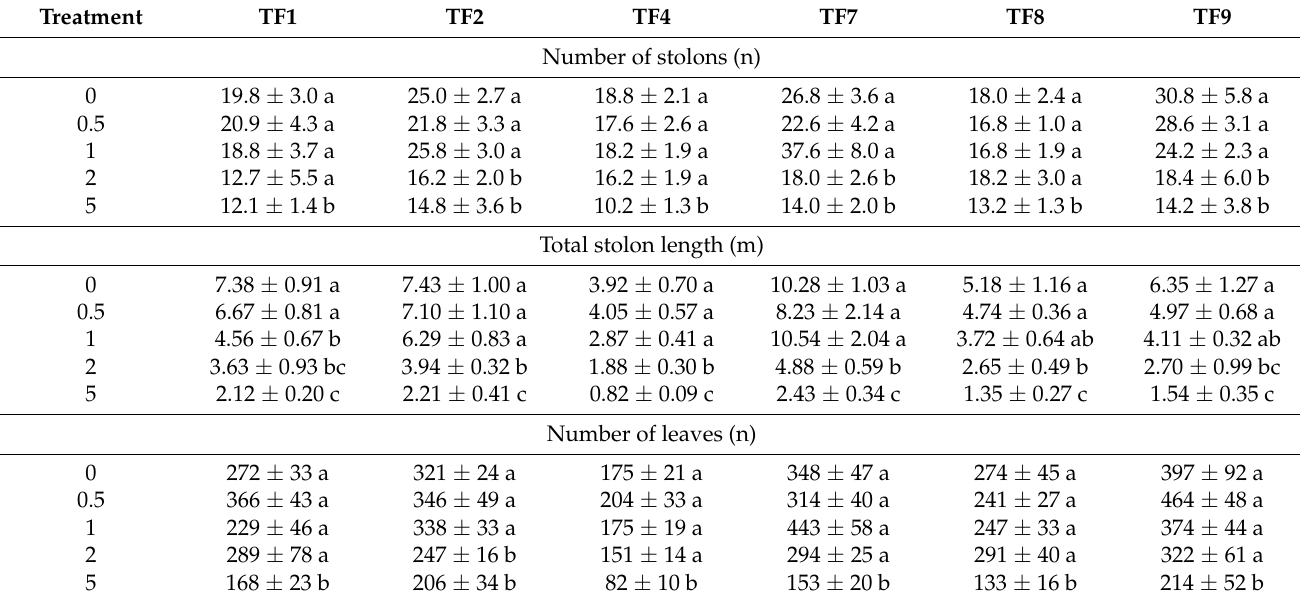
Different letters for each parameter within a column indicate statistically significant differences ( p < 0.05) between treatments for the respective accession.